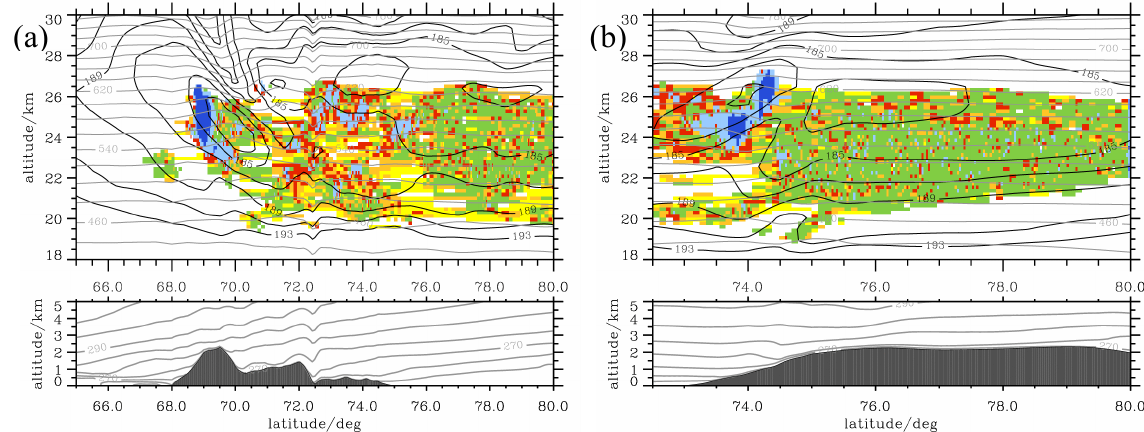
Fig. 16. Stratospheric gravity waves: CALIPSO PSC composition (blue: wave ice; light blue: ice, red: mixed 2 enhanced, orange: mixed 2; yellow: mixed 1; green: STS according to Pitts et al., 2011). ECMWF operational analyses interpolated at a regular 0 . 25 × 0 . 25 ◦ are superimposed: potential temperature (K, grey lines) and absolute temperature (K, black lines). (a) CALIPSO orbits at 05:03:43UTC and (b) at 13:18:09UTC on 4 January 2010.